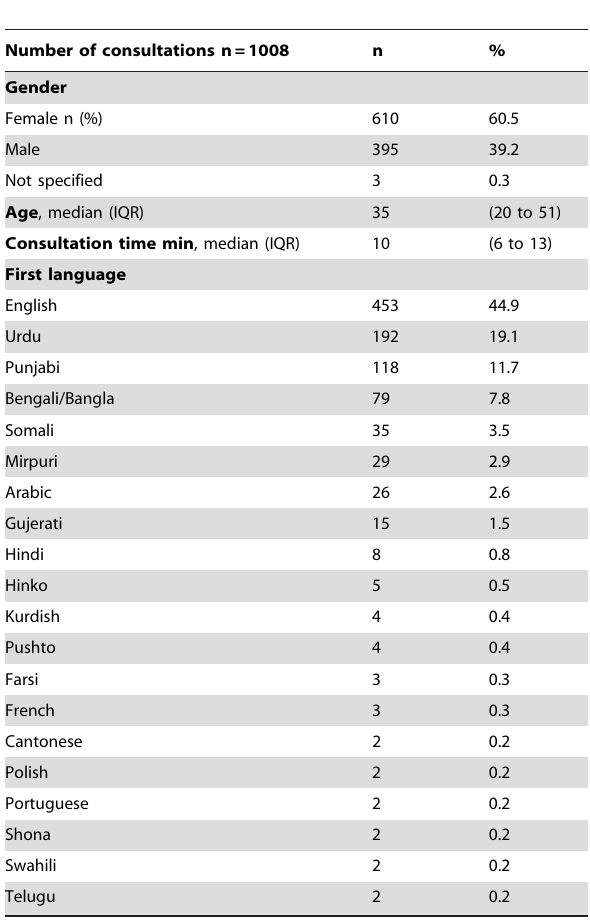
Table 3. Demographic and language characteristics of patients seen.